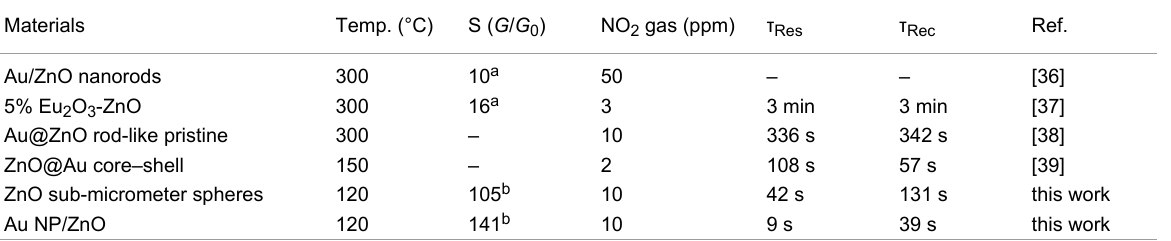
Table 1: Comparison of sensing performance between our proposed NO 2 sensors with some previously reported ZnO